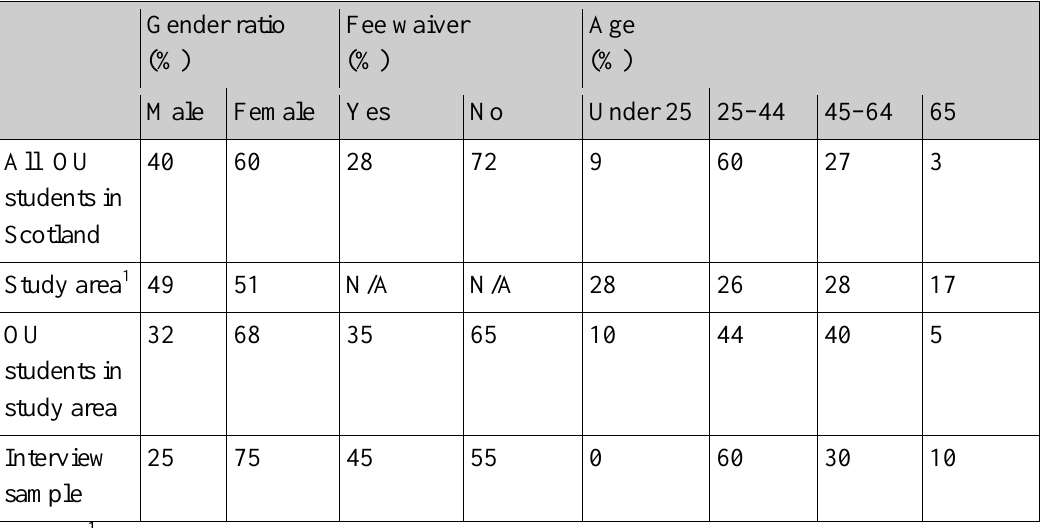
Profile of Sample and OU Students in Study Area in Relation to Study Area and OU Students